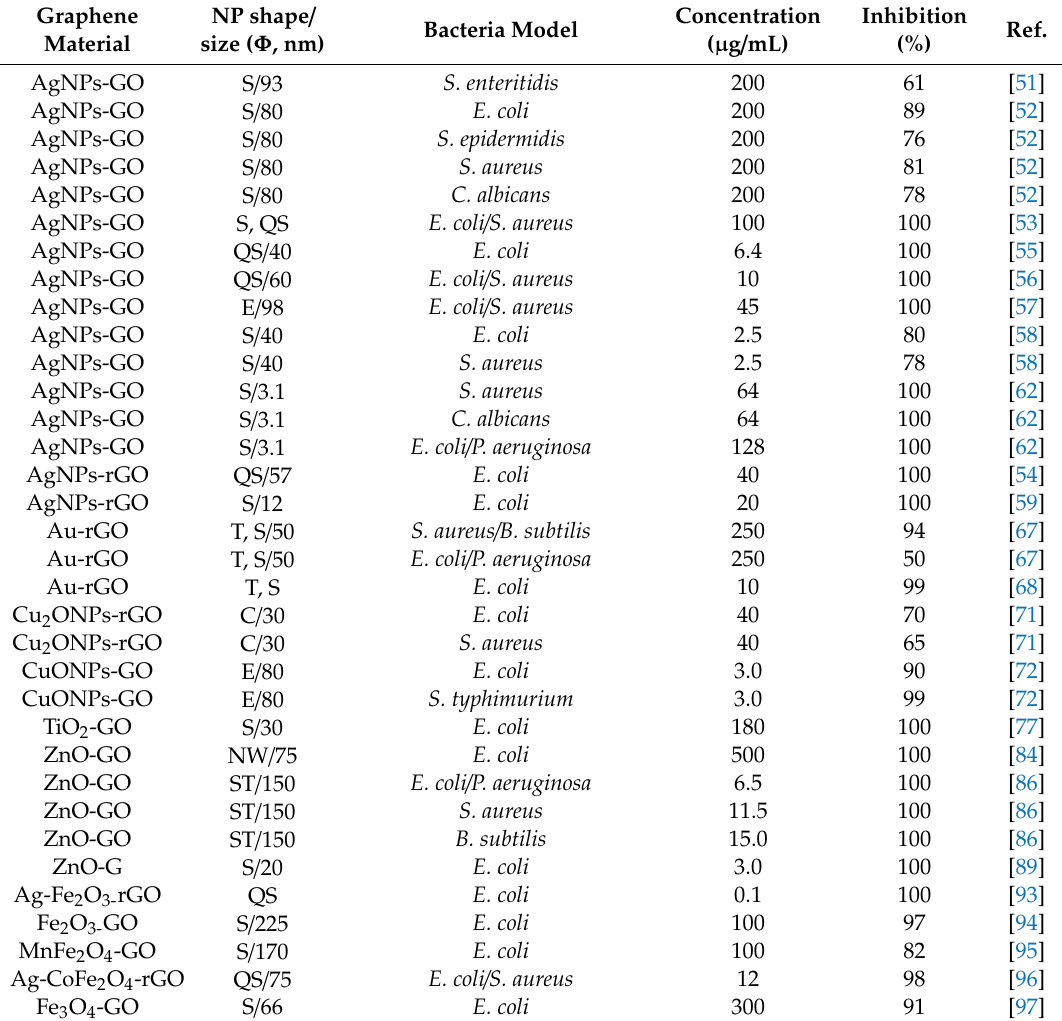
Table 1. Antibacterial properties of nanocomposites with graphene-based materials and inorganic NPs (S: spherical; QS: quasi-spherical; E: ellipsoidal; C: cubic; T: triangular; NW: nanowire; ST: